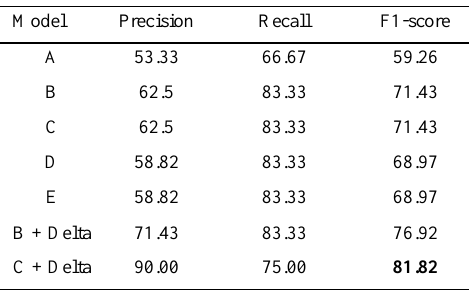
Table 9. Models performance on inference